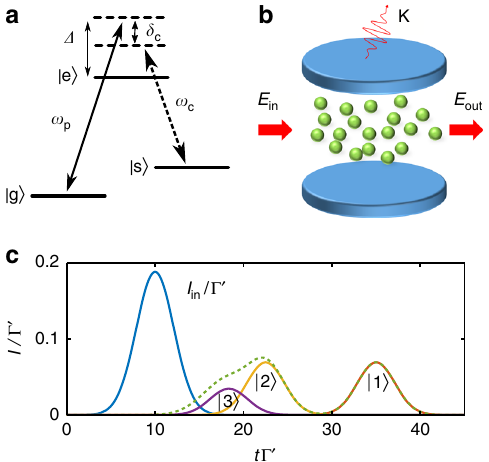
Fig. 3 Vacuum induced transparency. a Three-level atoms, where the transition | s 〉 - | e 〉 is coupled to a control or cavity fi eld with frequency ω c , allow for transparent propagation of probe photons ( ω p ) in EIT or VIT. b In VIT, an atomic ensemble is trapped inside an optical cavity where the atoms couple both to the probe fi eld E in and to a cavity mode, which is initially in its vacuum state. Photons in the cavity have an associated decay rate κ from transmission through the mirrors. c Idealized time-dependent transmission of a coherent pulse with average number of photons equal to one through a VIT medium. Here, the intensity (photons per unit time) is normalized by the single-atom decay rate Γ ′ into free space, while the time t is also normalized by Γ ′ . In the case where all loss mechanisms are ignored, as well as the effect of pulse distortion on entry and exit from the atomic ensemble, the individual Fock number state components | n 〉 of the input pulse (blue) propagate through the medium with group velocity v n ∝ n . This leads to separation of the one- (red), two- (yellow) and three- photon (violet) components of the output fi eld, and a total output intensity shown by the green dashed line. We have taken v 1 = 4 a Γ ′ and the medium has a length L = 100